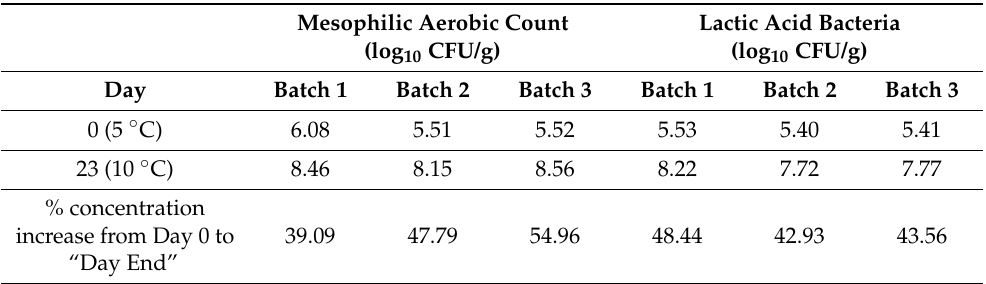
Table 6. Concentration of mesophilic aerobic count and lactic acid bacteria at “Day 0” and “Day End” in the control units of the three batches, and percentage of the increase of mesophilic aerobic count and lactic acid bacteria concentration during the studied